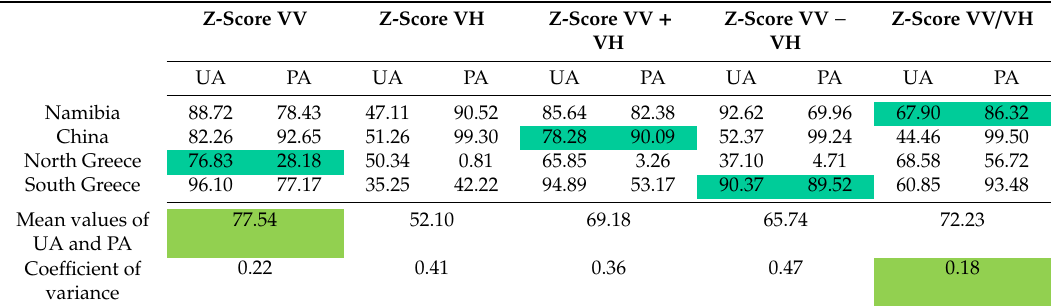
Table 7. The accuracy values PA and UA of the pixel-based classification for the individual study areas as a function of the five analyzed time series features. The relevant time series features for the individual study areas, which were identified by the Random Forest Algorithm (Section 3.1) and corresponding PA and UA values are highlighted in dark green. Optimum of statistical variables (mean value of UA / PA and coe ffi cient of variables) for time series features is highlighted in light green.